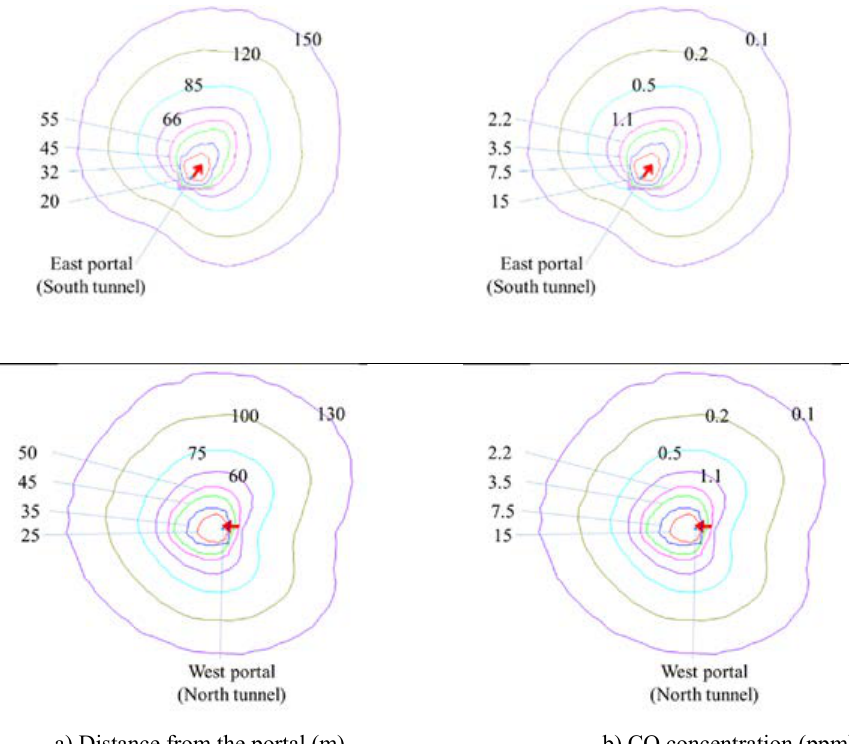
Fig. 5: Mean CO concentration (ppm) in different layers–5m